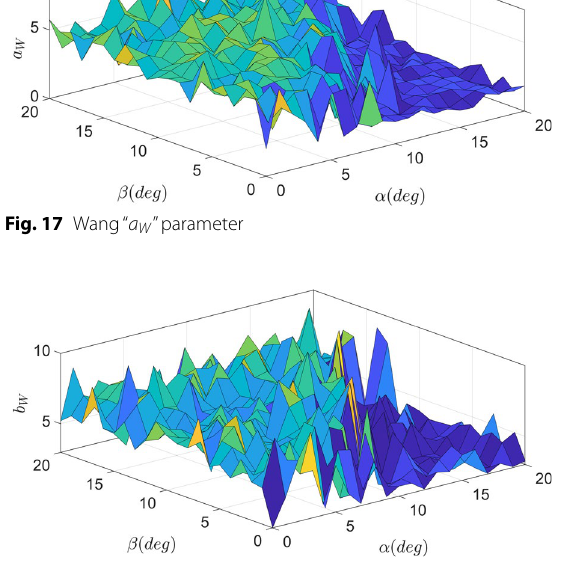
Fig. 18 Wang “ b W ” parameter